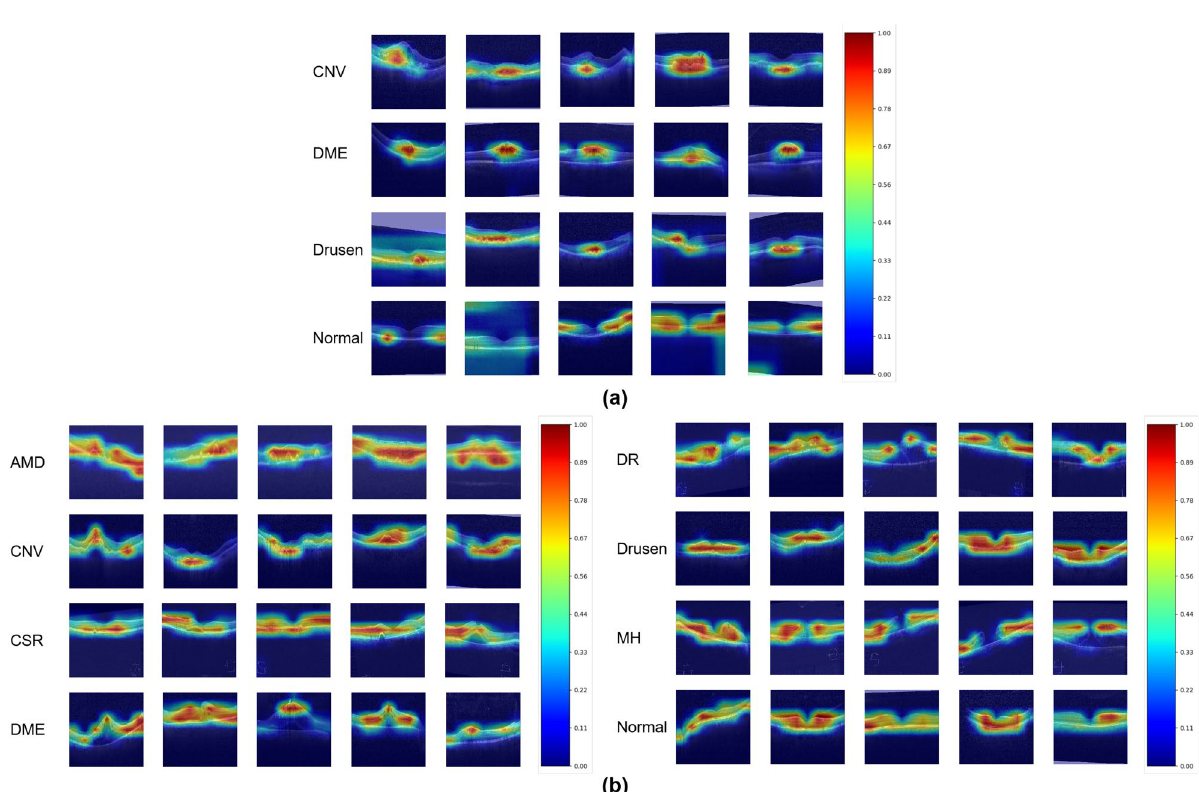
Figure 5. Confidence score maps on ( a ) OCT2017 and ( b ) OCT-C8 of proposed Swin-Poly